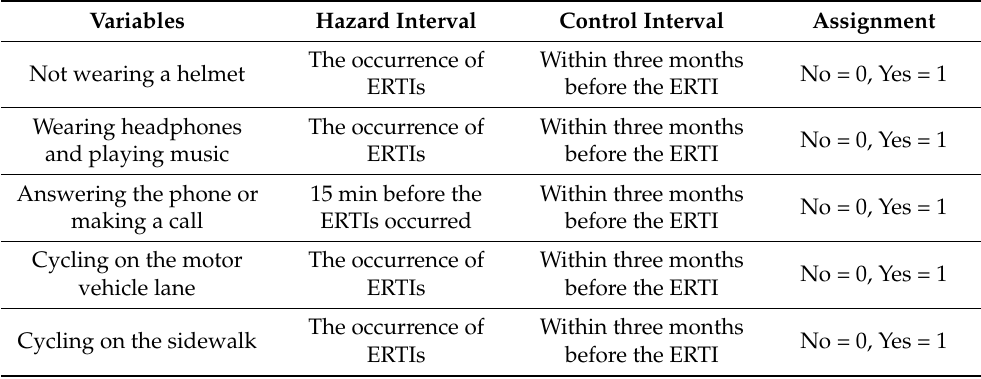
Table 6. Assignment of case-crossover study